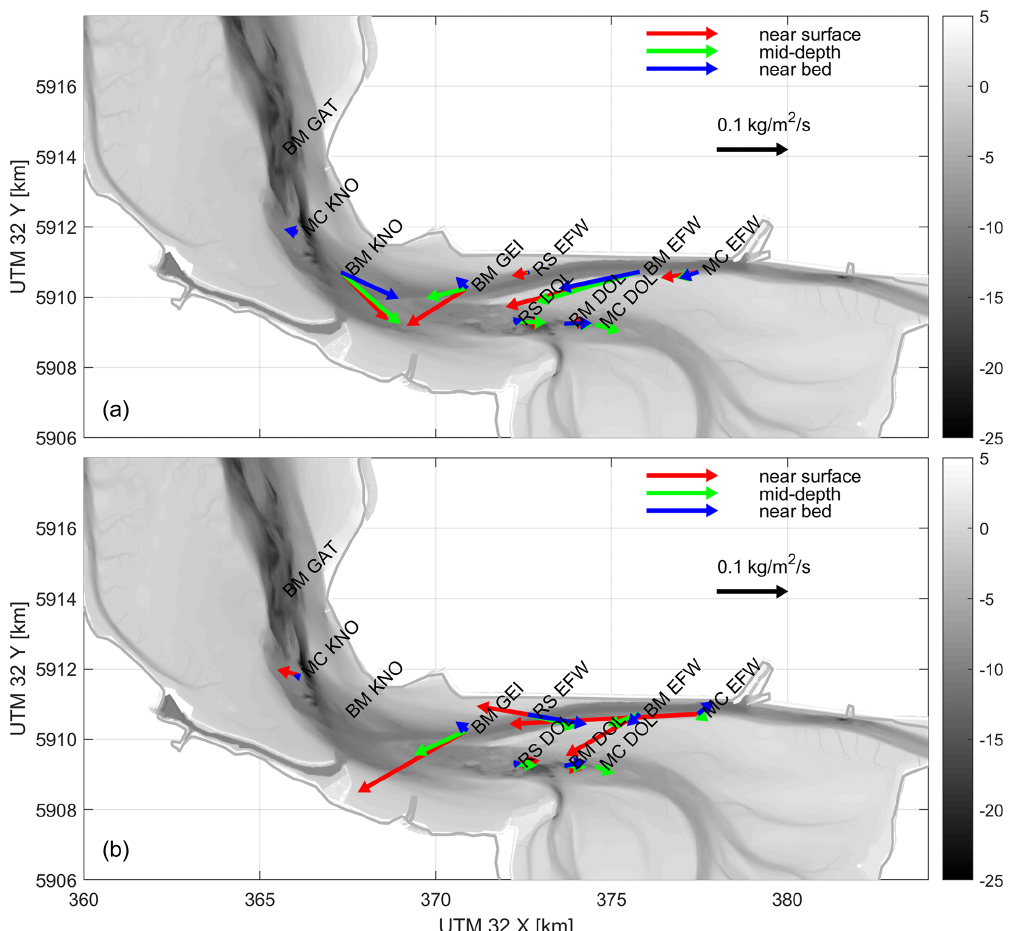
Figure 8. Residual sediment transports (kgm − 2 s − 1 ) computed at all observation stations with a length exceeding the duration of a spring– neap cycle in 2018 (a) and 2019 (b) for which velocity and SSC observations are available. At MC stations, velocities at three positions in the vertical are multiplied with SSC at the same position. At other locations, velocity profiles as collected by an ADCP are multiplied with near-bed SSC.